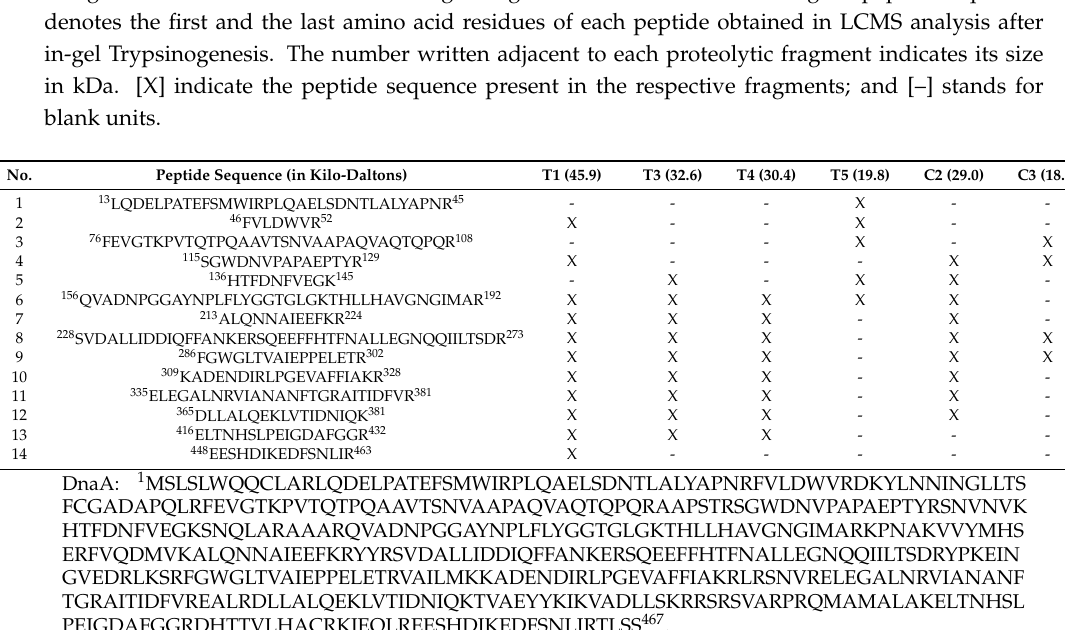
Table 1. Differential proteolytic cleavages sites between ADP-DnaA and ATP-DnaA reside in domains I, II and III. Peptide sequences of the in-gel trypsin digested fragments (T1, T3, T4, T5 and